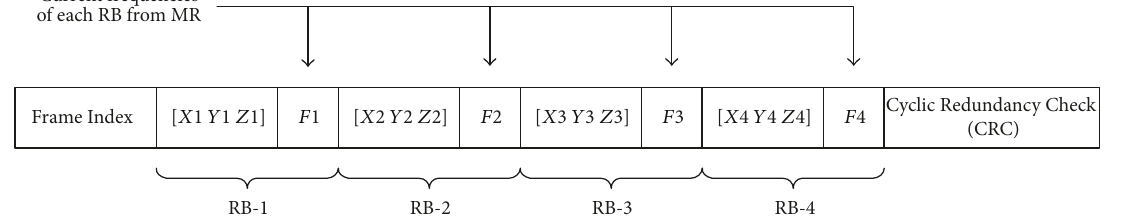
Figure 2: Frame structure of the modulating signal.